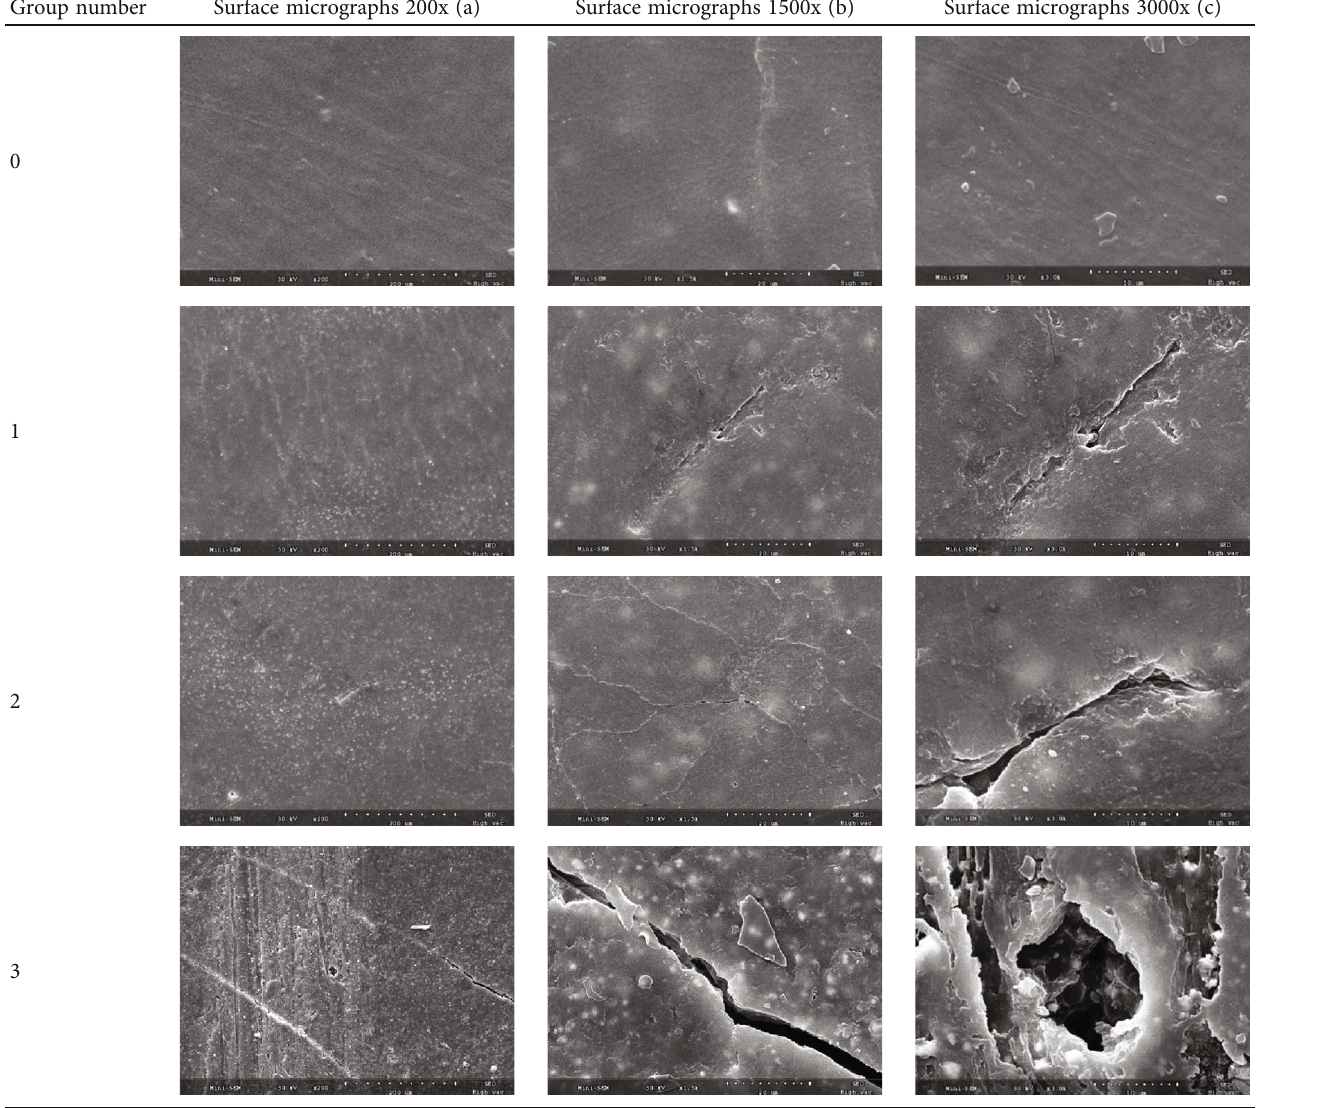
Table 6: Scanning micrographs of coated fabric surface performed at 200, 1500, and 3000x. Group